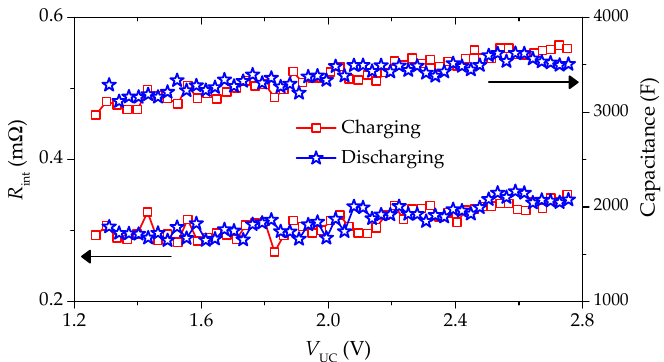
Figure 2. Internal resistance and capacitance of symmetric double-layer UC measured at a constant current of 50 A for charge–discharge cycles.